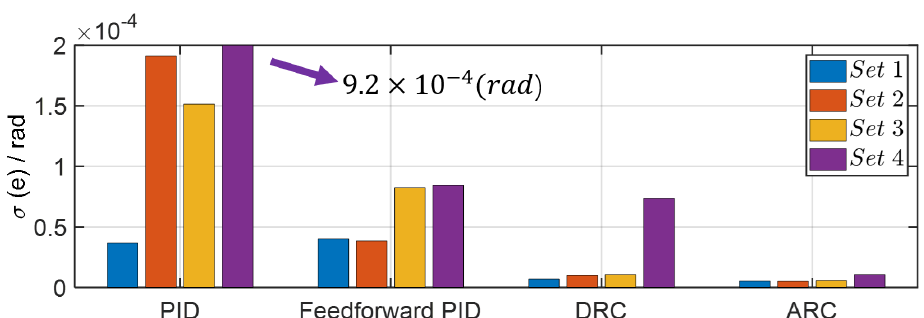
Figure 9. Maximum tracking error in 4 controllers.